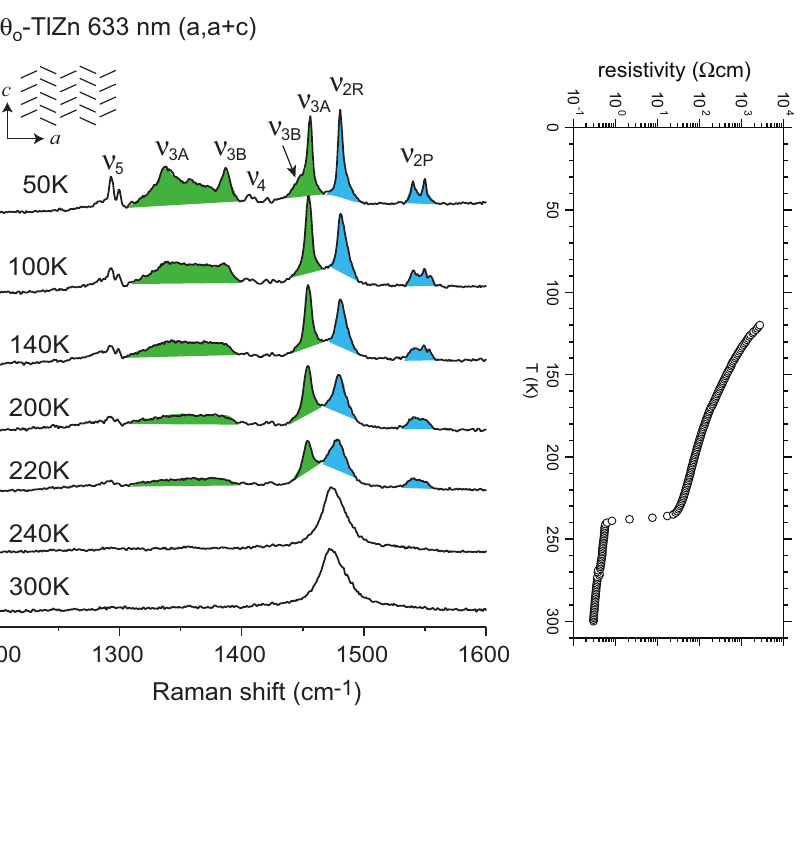
-(BEDT-TTF) TlZn(SCN) o 2 4 RbZn(SCN) . The Raman spectrum is modified from 2 4